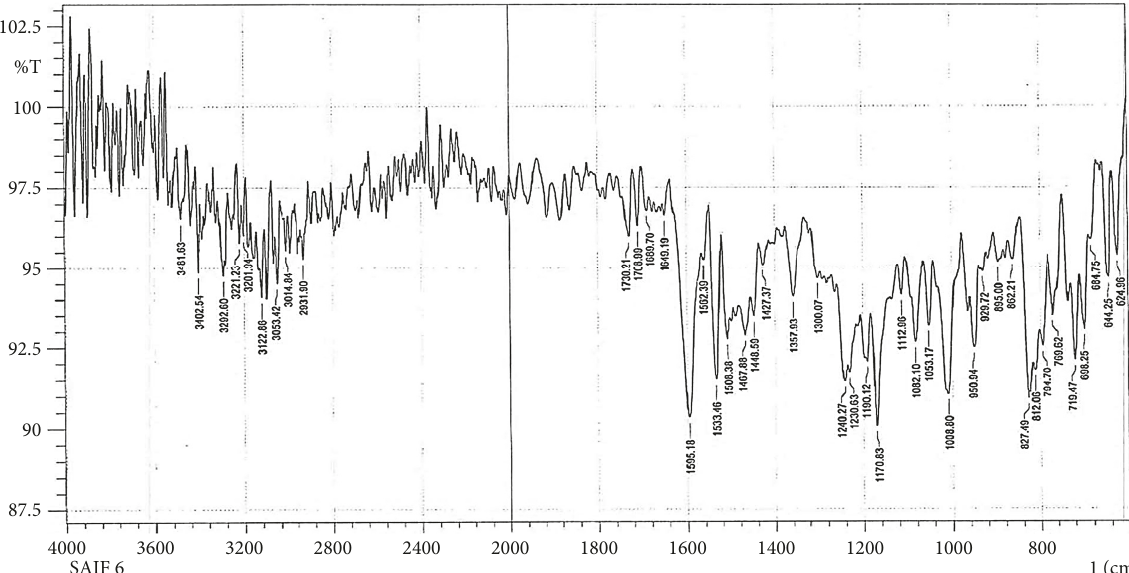
Figure 3: Fourier Transform Infrared Spectrum of S6.